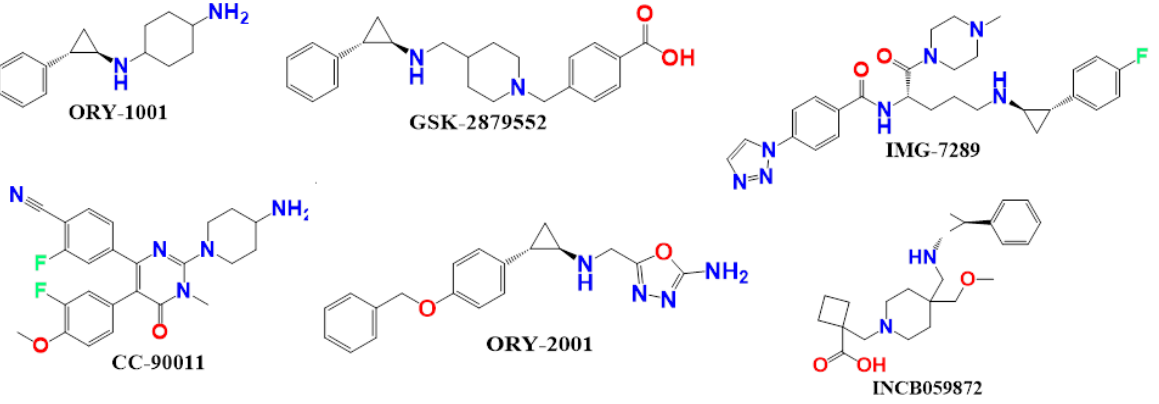
Figure 1. Presentation of the Structures of some clinical trial molecules.